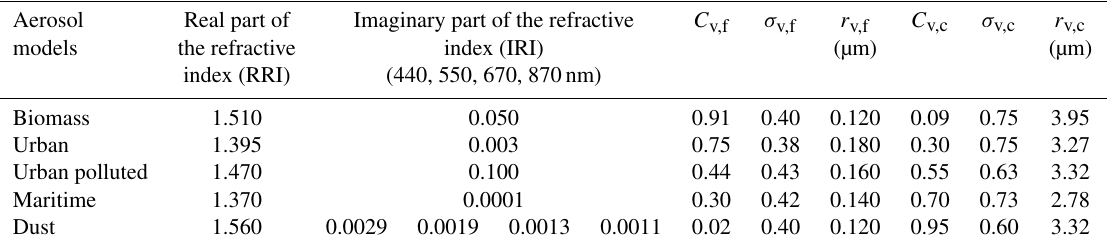
Table 4. Details on the complex refractive index and particle size distribution parameters used for the aerosol models. C v is the concentration, σ v is the SD of the distribution, and r v is the volume median radius. Fine- and coarse-mode parameters are indicated by f and c subscripts, respectively. Aerosol Real part of Imaginary part of the refractive C v,f σ v,f r v,f C v,c σ v,c r v,c models the refractive index (IRI) (µm) (µm) index (RRI) (440, 550, 670, 870nm) Biomass 1.510 0.050 Urban